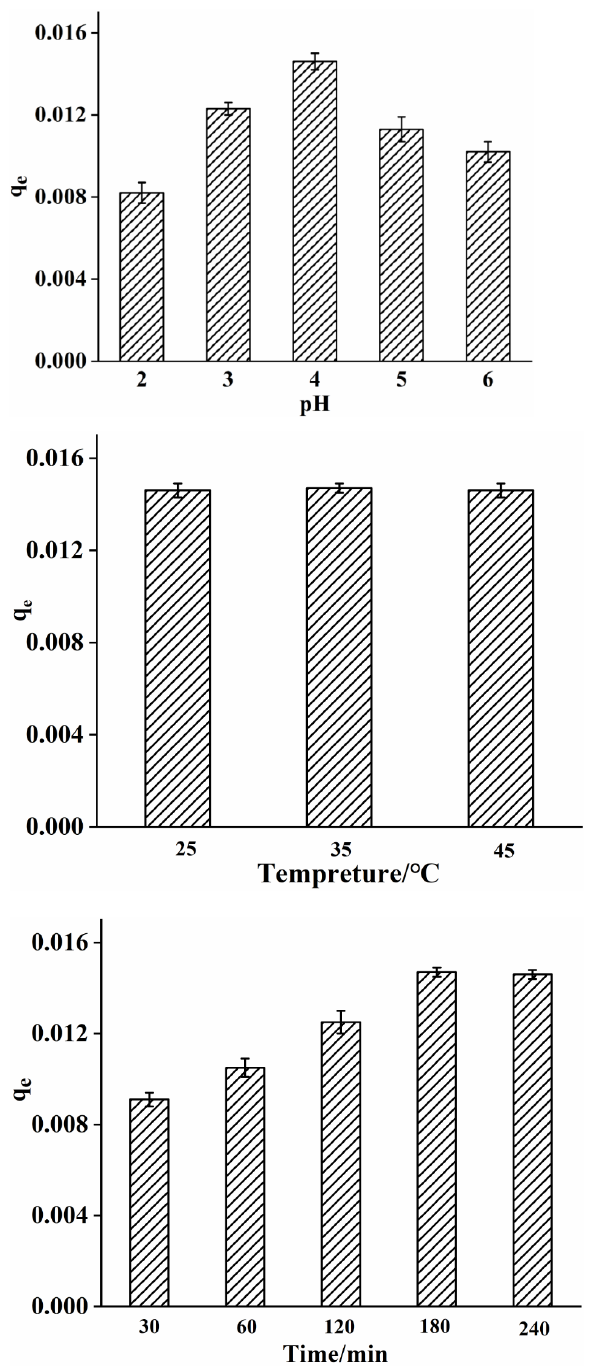
Figure 9. Adsorption performance of nylon6/pig nail keratin nanofiber membranes under different concentrations.